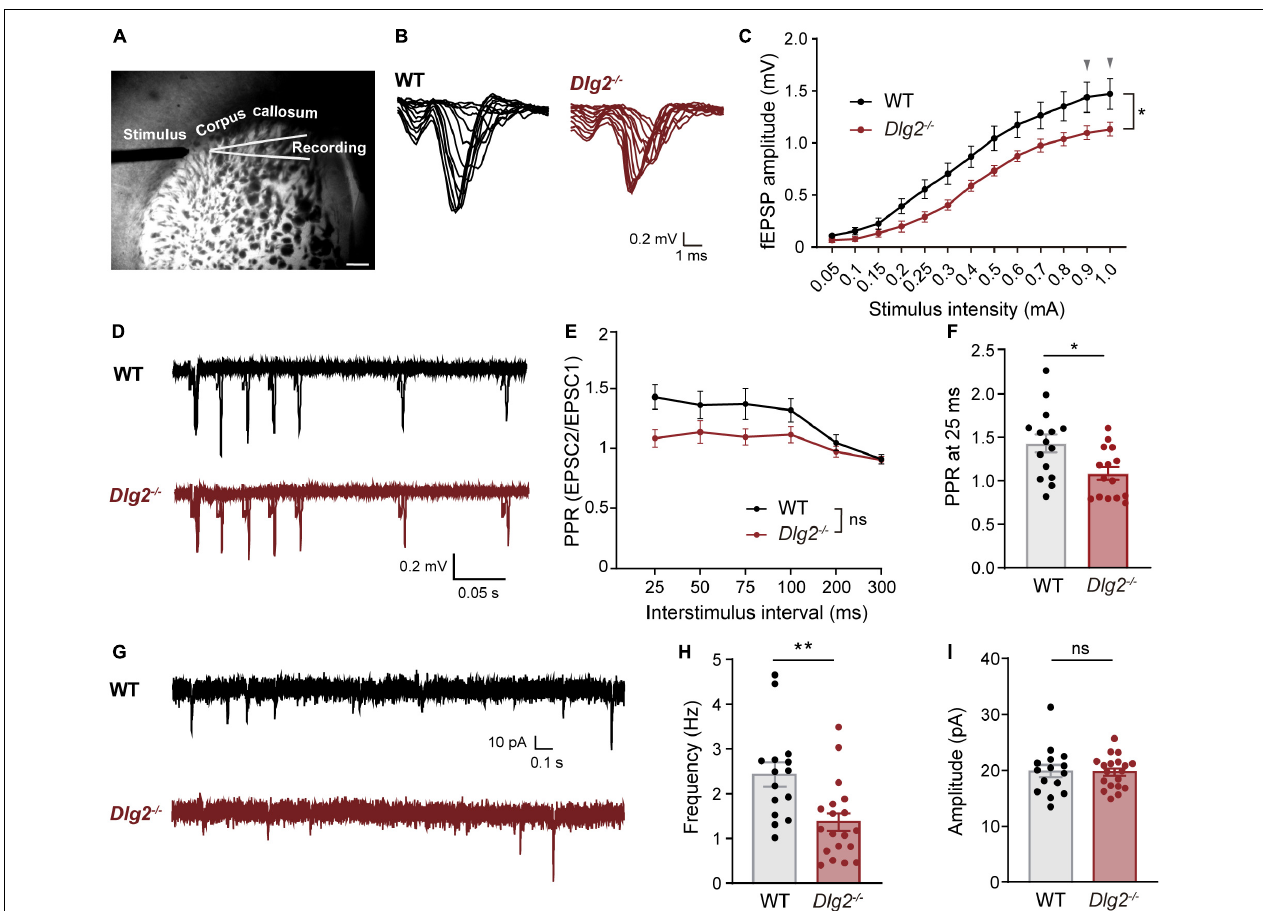
FIGURE 1 | Corticostriatal synaptic transmission is suppressed in Dlg2 -/- mice. (A) Representative micrograph of the dorsolateral striatum region showing placement of extracellular field recordings and stimulus via the corpus callosum. Scale bar, 400 µ m. (B) Representative traces of input-output measurements were performed by extracellular field recordings for WT and Dlg2 -/- mice. (C) The amplitude of corticostriatal fEPSPs was significantly reduced in Dlg2 -/- mice ( n = 15 slices from three WT mice and n = 15 slices from three Dlg2 -/- mice). Arrowheads indicate p -values being 0.05 in post hoc Sidak’s multiple comparisons tests (see details for Supplementary Table 1 ). (D) Representative traces of paired-pulse ratio (PPR) from WT and Dlg2 -/- mice. Paired-pulse ratio, as shown by fEPSP amplitude plotted against interstimulus intervals, was not significantly altered overall in Dlg2 -/- mice in repeated measures of ANOVA (E) , but at 25 ms (F) , it was significantly reduced in Dlg2 -/- mice ( n = 15 slices from three WT mice and n = 15 slices from three Dlg2 -/- mice). (G) Representative traces of whole-cell patch-clamp recordings of miniature excitatory postsynaptic currents (mEPSCs) from WT and Dlg2 -/- mice. (H) The frequency of mEPSCs was decreased in striatal SPNs of Dlg2 -/- mice compared with that in WT mice, suggesting the corticostriatal dysfunction attributable to a smaller number of functional synapses in the striatum of Dlg2 -/- mice than that of WT. (I) There was no group difference in the amplitude of mEPSCs. n = 15 neurons from three WT mice and n = 19 neurons from four Dlg2 -/- mice. Student’s t -test (mEPSC frequency) and the Mann-Whitney test (mEPSC amplitude) were used according to the normality of the data. * p < 0.05; ** p < 0.01; ns, not significant.